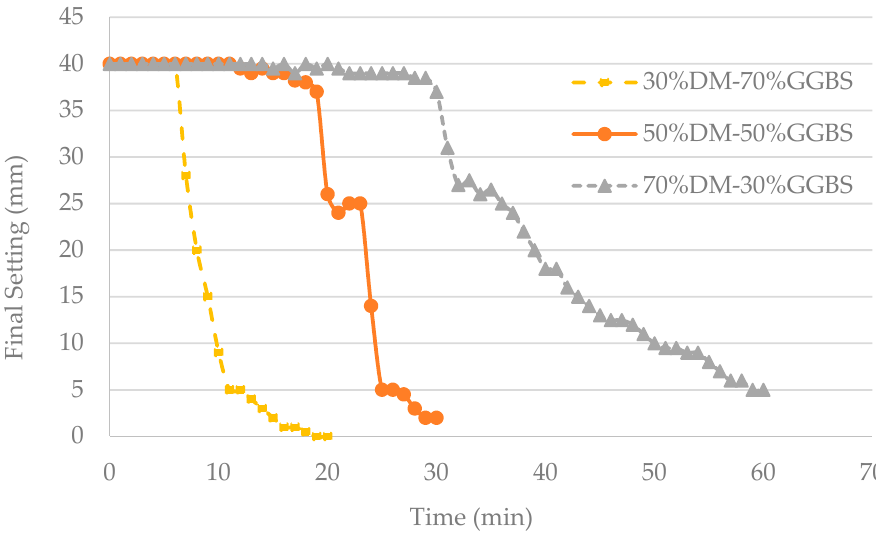
Figure 2. Setting (mm) vs. time (min) plots for the 3 DM–GGBS mixtures developed.